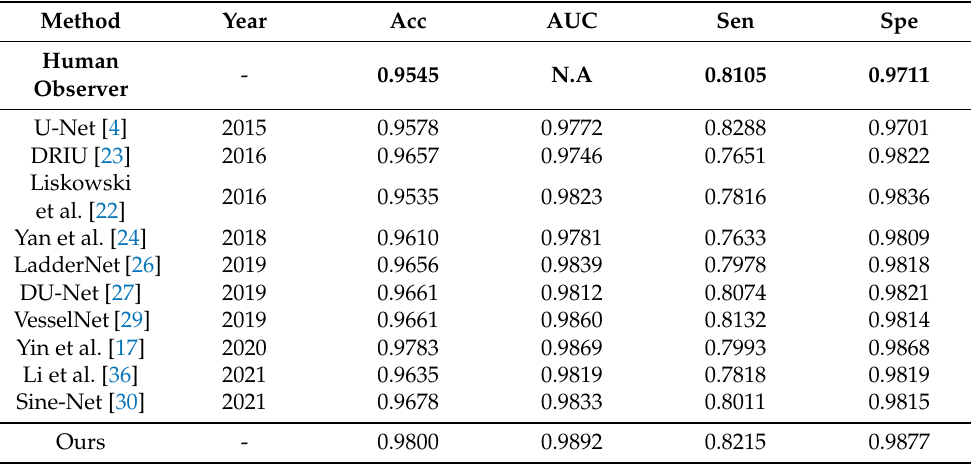
Table 2. Segmentation performance of CHASEDB1 inside